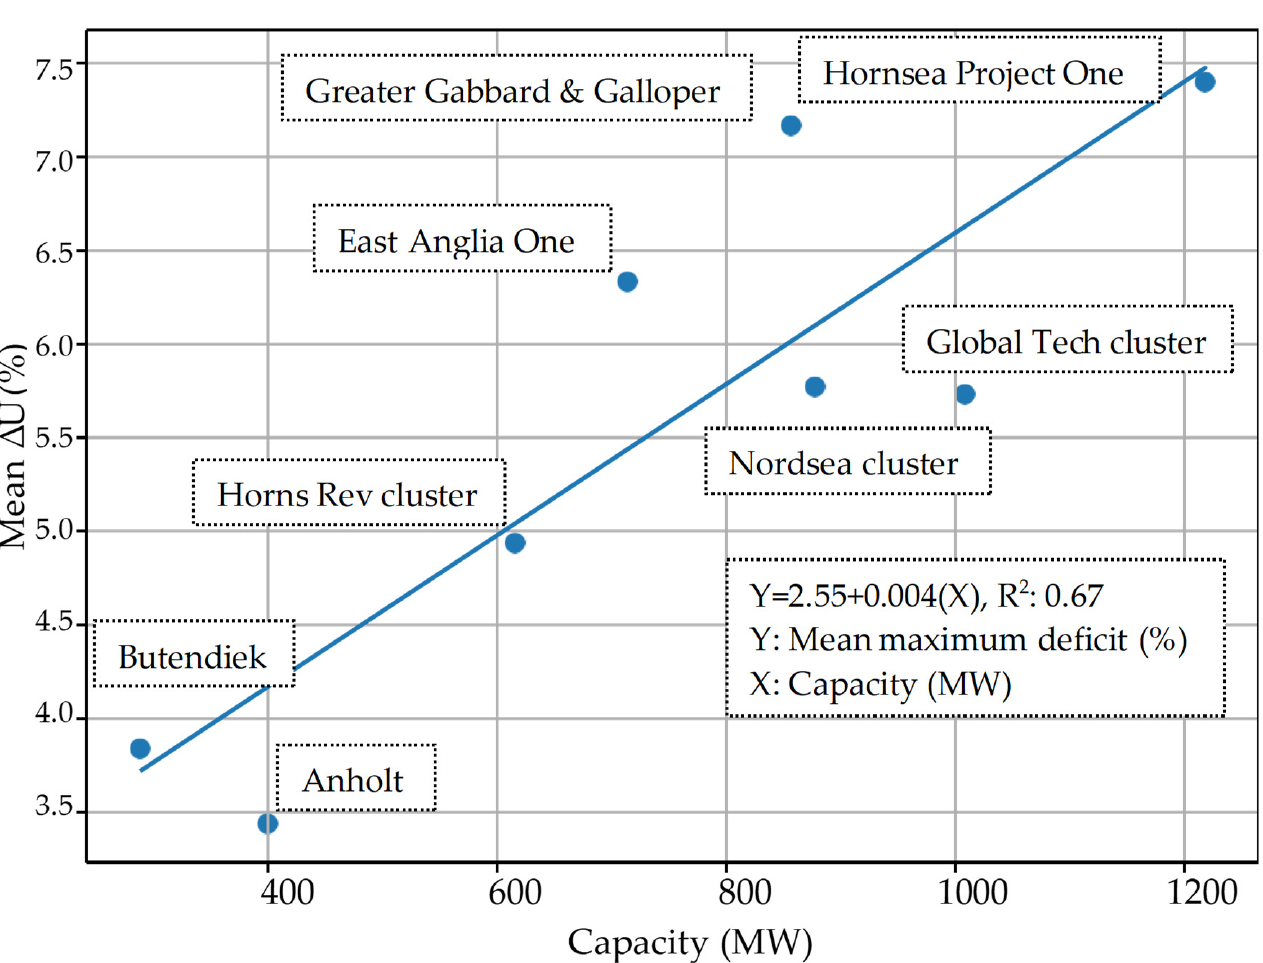
Table 4. Maximum velocity deficit ( 𝛥𝑈) detected within the first 5 km downstream of the OWFs and clusters.